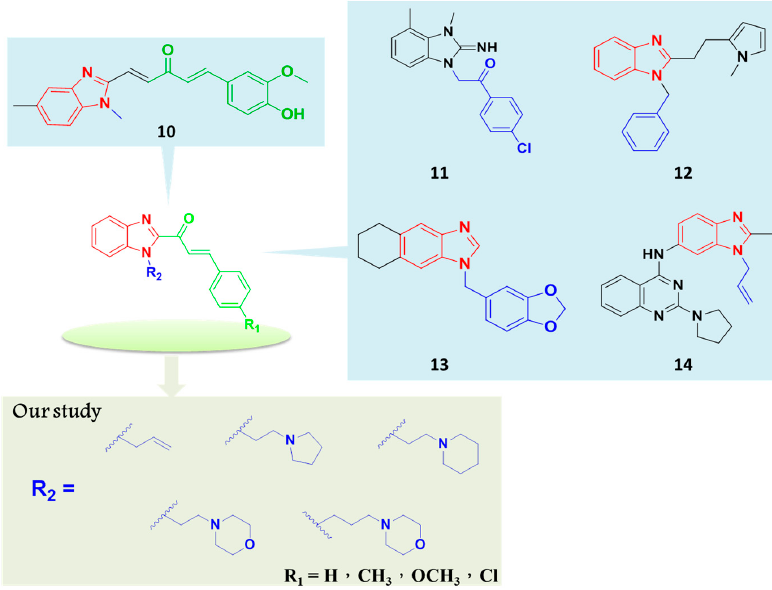
Figure 3. Reported and proposed anticancer benzimidazole